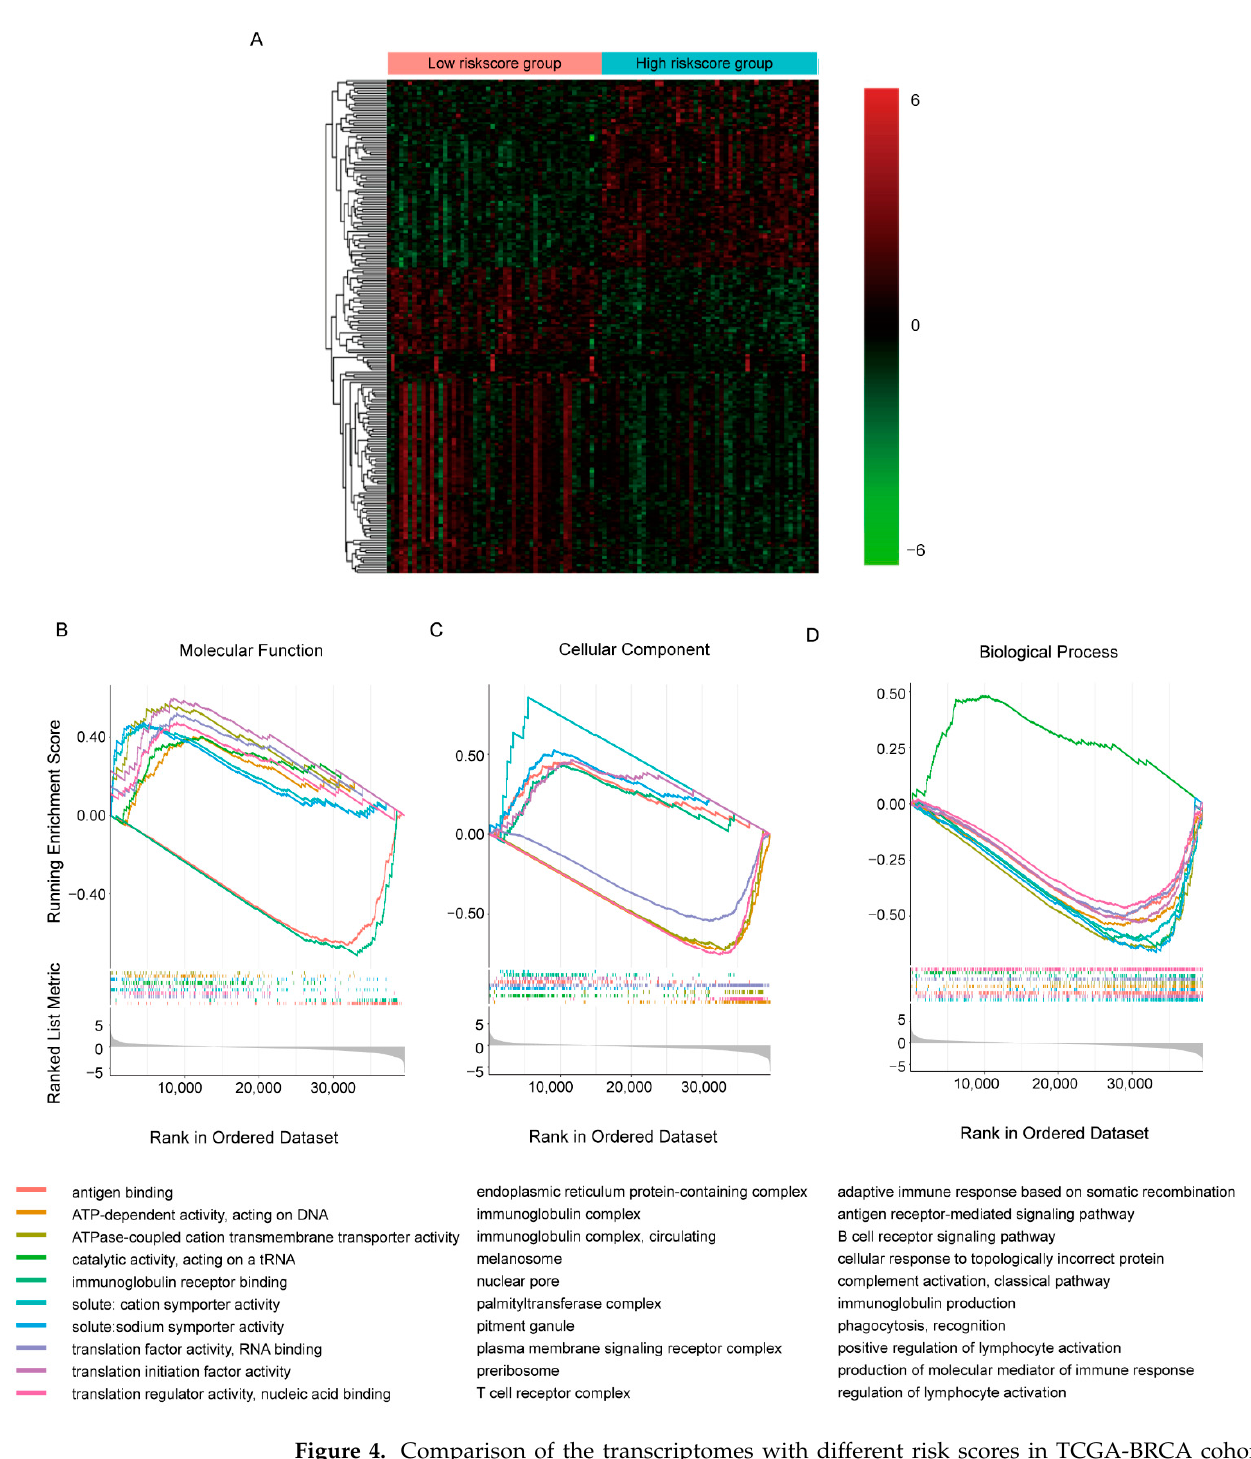
Figure 4. Comparison of the transcriptomes with different risk scores in TCGA-BRCA cohorts. ( A ) Heatmap of top 200 DE transcripts between samples with 50 highest/lowest risk scores. ( B – D ) GSEA plots of commonly enriched GO pathways in the TCGA-BRCA cohort. The pathways shown here were top 10 most significantly enriched ( p < 0.05).